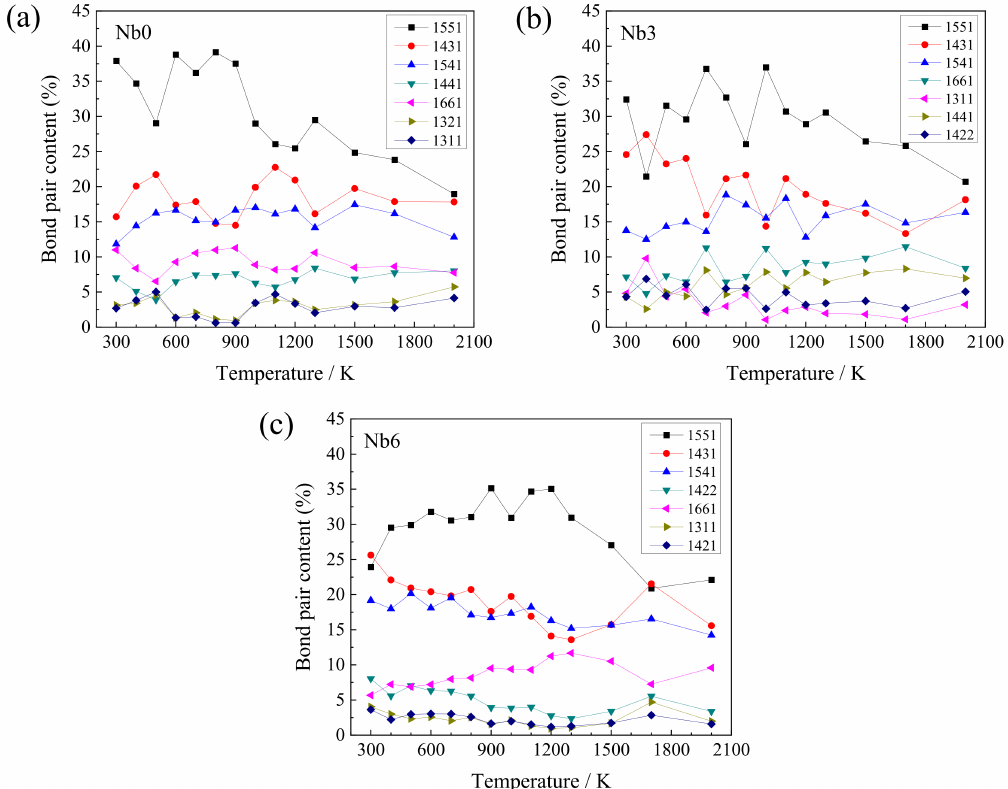
Figure 6. Changes of bond pair content in simulated Nb0, Nb3 and Nb6 during cooling from 2000 K to 300 K: ( a ) Nb0; ( b ) Nb3 and ( c ) Nb6.